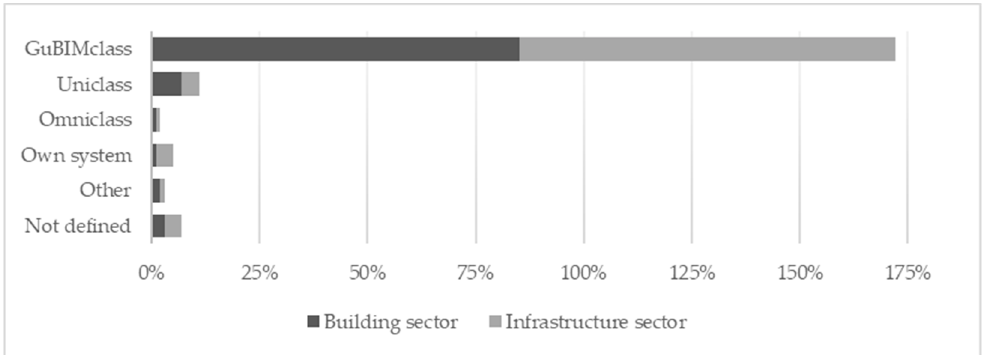
Figure 7. Definition of a classification system in contracts by sectors. Source: Own elaboration based on [33].